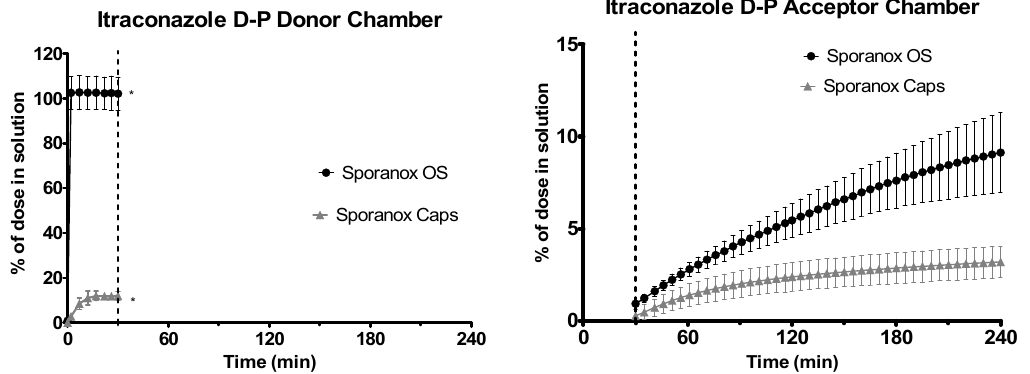
Figure 9. Drug release time profile for the itraconazole dose equivalent to 2.5 mg API using the D-P apparatus. Sporanox ® OS and Sporanox ® Capsules are represented by black circles and grey triangles, respectively. Left: Percentage release profile in the donor chamber. Right: Percentage release profile in the acceptor chamber. Dotted line indicates transition from gastric sector to intestinal sector. * indicates where UV blackout has occurred in the aqueous phase due to precipitation and / or limitations of quantification. Each data point represents the mean ± SD ( n = 3).